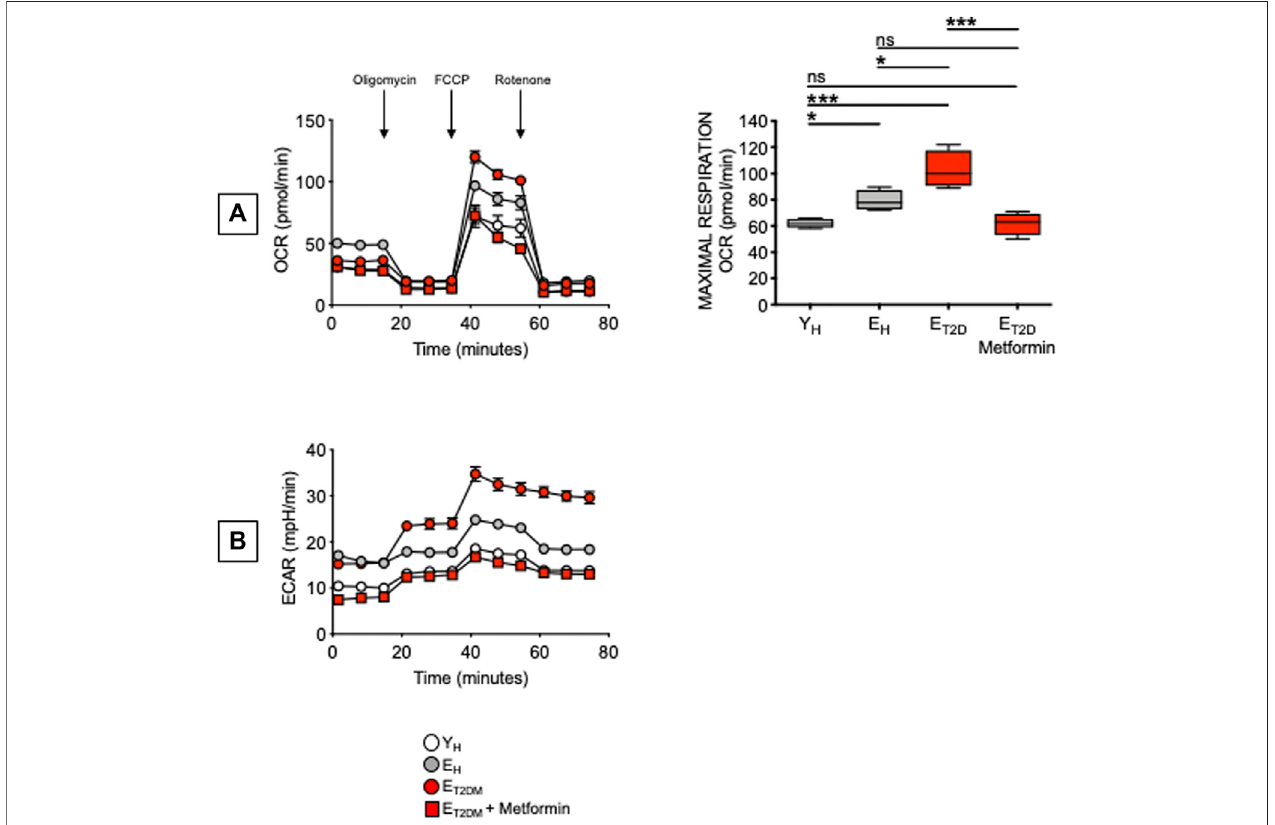
FIGURE 5| Metformin decreases OCR and ECAR in exvivo-isolated Bcells from E T2DM patients. B cells were seeded into the wells of an extracellular fl ux analyzer at the concentration of 2 × 10 5 /well in triplicate and run in a mitostress test. (A) OCR results (left) and maximal respiration results (right) are shown. Mean comparisons between groups were performed by one-way ANOVA. * p < 0.05, *** p < 0.001. (B) ECAR results.